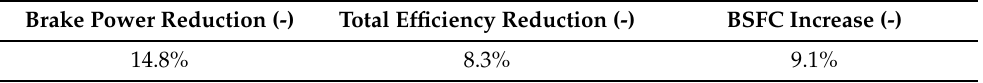
Table 6. Assessment of the POCS pressure drop: engine performances analysis.